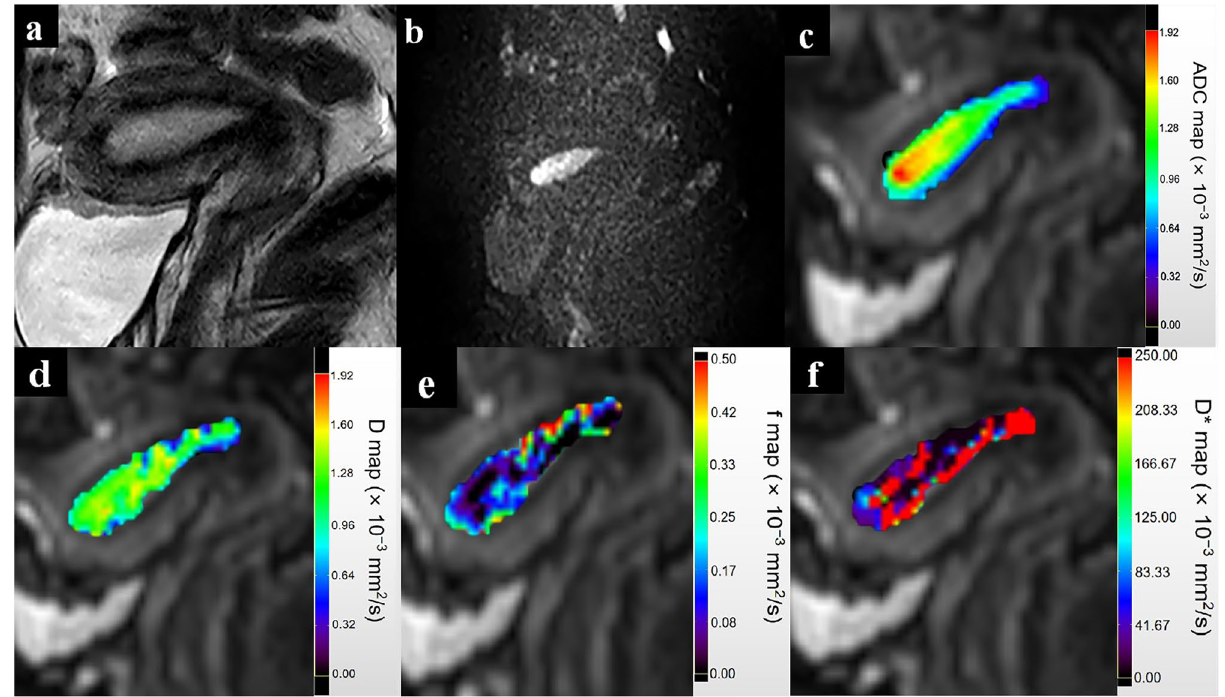
Figure 2. A 24-year-old healthy woman. ( a ) Sagittal T2-weighted turbo spin-echo (TSE) image demonstrates the long ribbon shape normal endometrium with high signal intensity. ( b ) Sagittal diffusion-weighted image (b = 800 s/mm 2 ) of the uterus. Parametric maps of ADC ( c ), D ( d ), f ( e ) and D* ( f ) demonstrate that the average ADC, D , f and D* values of the normal endometrium are 1.51 × 10 −3 mm 2 /s, 1.36 × 10 −3 mm 2 /s, 0.12 and 66.82 × 10 −3 mm 2 /s, respectively. ADC apparent diffusion coefficient, D true diffusion coefficient, f perfusion fraction, D* pseudodiffusion coefficient.